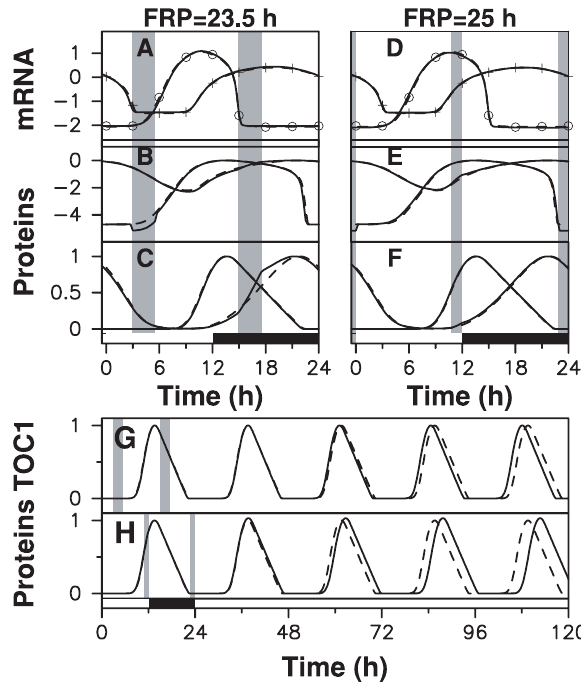
Figure 9. Adjustment by models with gated coupling when FRP is different from 24 hours. Gated coupling can also synchronize free-running clock models with a FRP of 23.5h or 25h without leaving any signature in mRNA profiles. Top left, (A)–(C): numerical solutions of model (2) for a FRP of 23.5h, subjected to coupling windows shown as shaded areas. TOC1 (resp. CCA1) protein degradation rate is multiplied (resp. divided) by three from ZT3 to ZT5.5 (resp. ZT15 to ZT17.5). Top right, (D)–(F): numerical solutions of model (2) for a FRP of 25h, subjected to coupling windows shown as shaded areas. TOC1 (resp. CCA1) protein degradation rate is multiplied (resp. divided) by three from ZT22.75 to ZT24 (resp. ZT11.75 to ZT12). (A), (D) RNA in log scale; crosses (resp. circles) indicate Cca1 (resp. Toc1 ) microarray data; (B), (E) proteins in log scale; (C), (F) proteins in linear scale. In bottom panel, time evolution of TOC1 protein level (solid lines) during a transition from a 24-hour light/dark cycle to constant light compared to the forced profile (dashed line) for (G) a FRP of 23.5h and (H) a FRP of